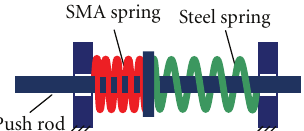
Figure 2: Operational principle of the SMA